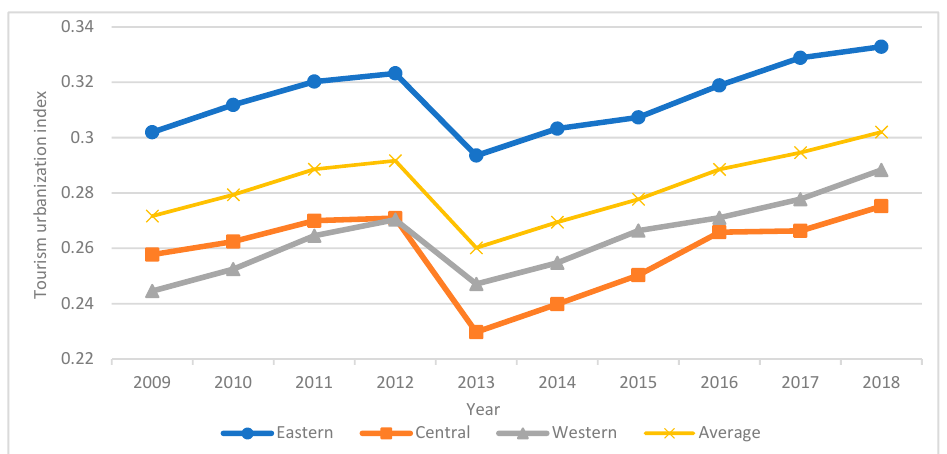
Figure 5. Changes in the tourism urbanization index in the eastern, central and western regions over time.